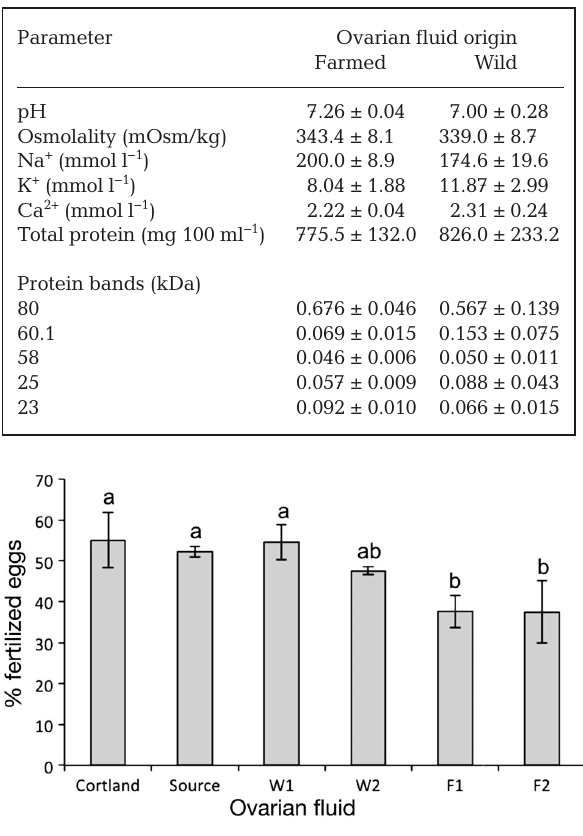
Fig. 4. Percentage of fertilized eggs in the presence of Cort- land solution and ovarian fluids of the egg source female and that of 2 wild (W1, W2) and 2 farmed (F1, F2) non-egg source females (Expt 2). Different letters indicate significant differ- ences between the groups as detected by Duncan’s multiple comparison test. Values are means for the 2 batches ±